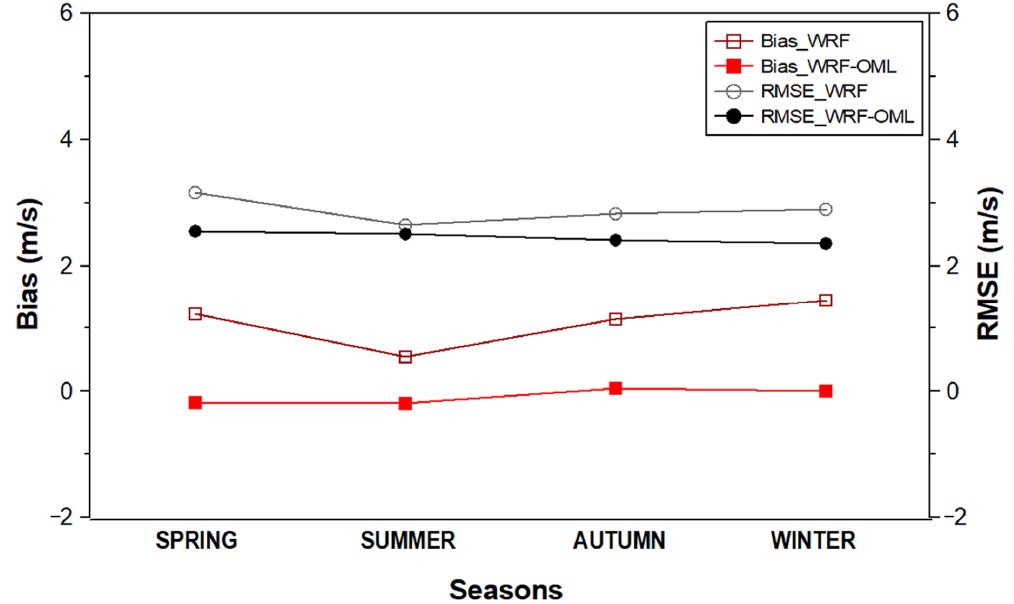
Figure 9. Bias and RMSE of the simulated results using the WRF and WRF-OML (wind speed at 94 m height) models with seasons. Spring is March to May, summer is June to August, autumn is September to November, and winter is December to February.